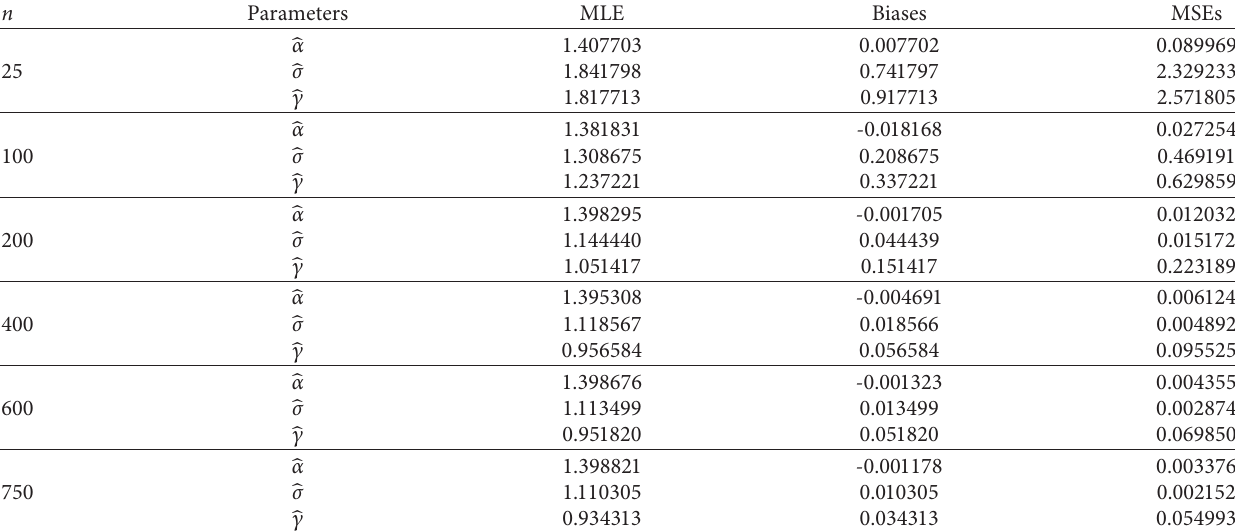
Table 2: Simulation results of the L-Claim distribution for α � 1 . 4, c � 0 . 9, and σ � 1 .